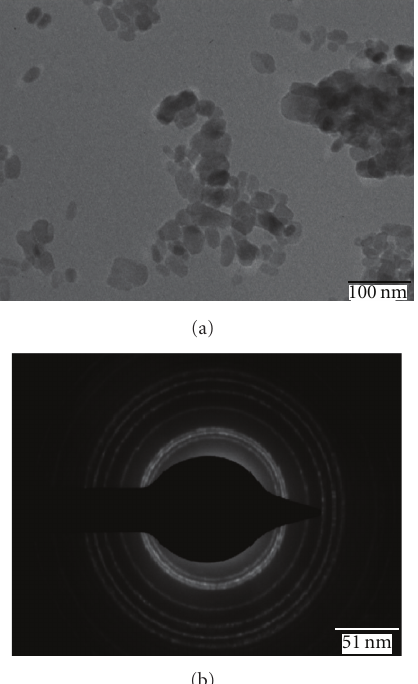
Figure 1: (a) TEM image of nano-ZnO Particles. (b) SAED pattern of nano-ZnO